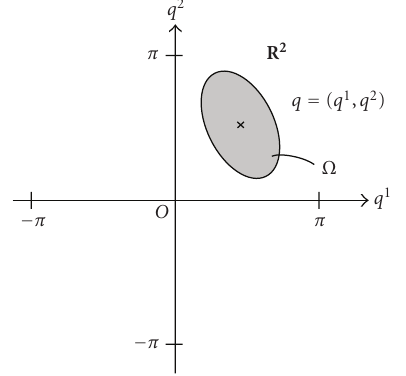
Figure 2: A homeomorphism φ : U → Ω is called a chart.